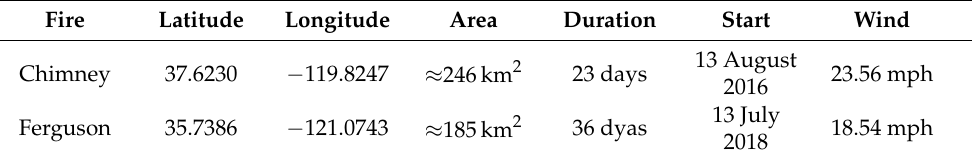
Table 1. Study areas of the Chimney and the Ferguson wildfire events in this work. The latitude and the longtitude represent the centre of the fires. The averaged wind speed of the first 6 days of fire propagation is also